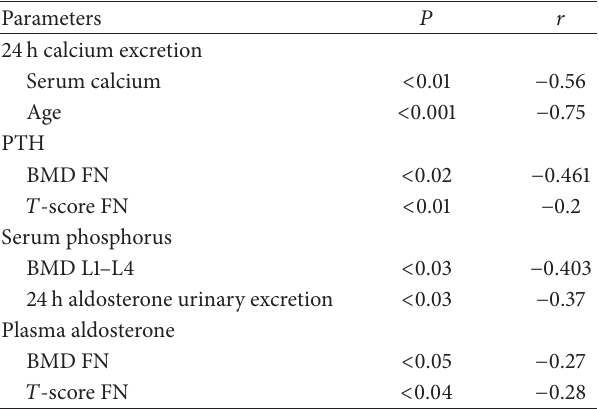
Table 5: Study correlation in PA subjects.